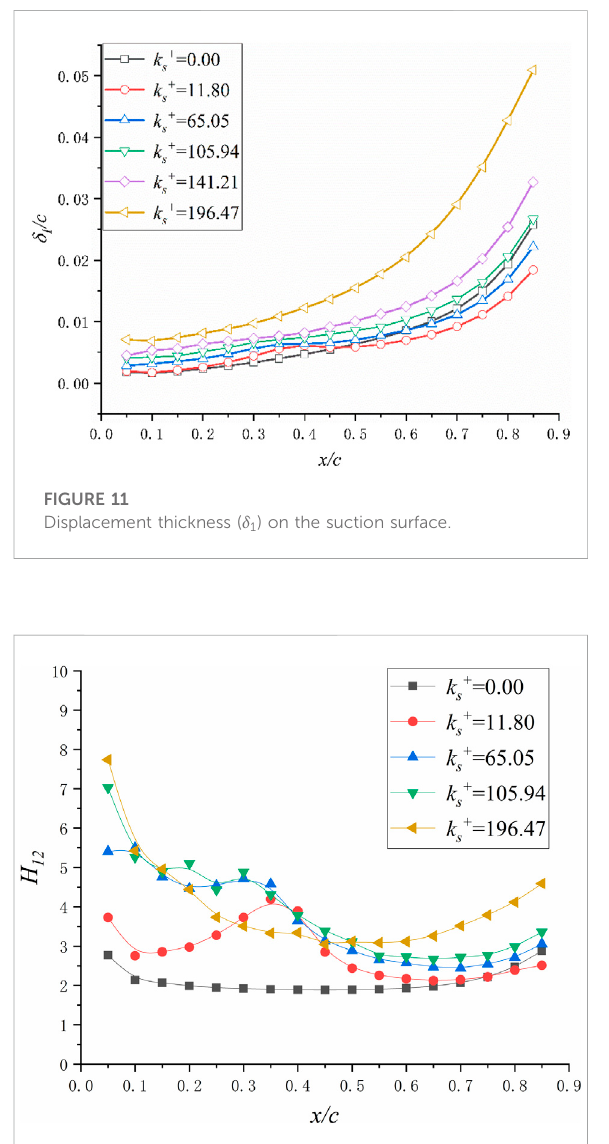
FIGURE 12 H 12 on the suction surface.